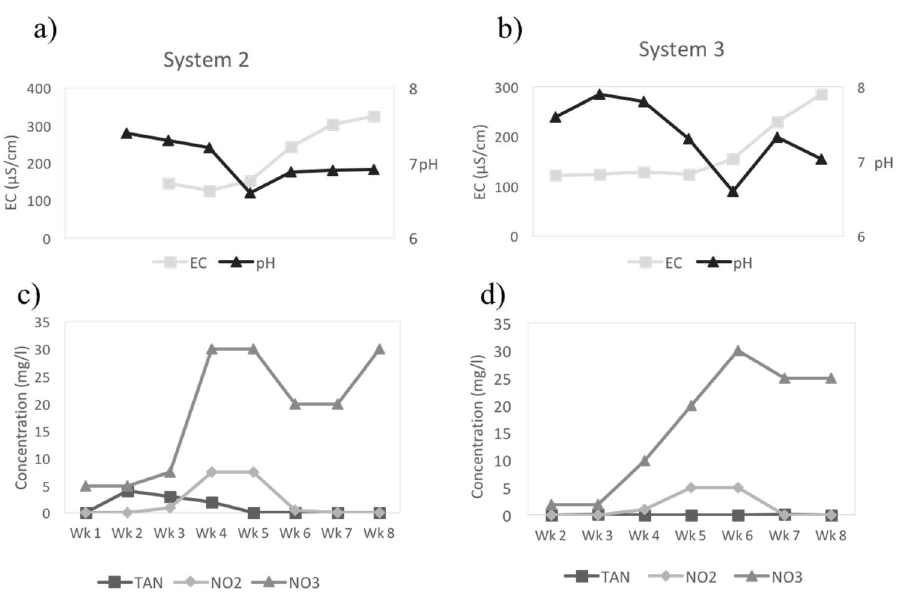
Figure 4. Biofilter stabilization in Systems 2 and 3: ( a , b ) show the measured conductivity (EC) and pH whereas ( c , d ) show the N-species dynamics in the system. All N-species are reported as N (TAN, NH 4 -N, nitrite, NO 2 -N, and nitrate, NO 3 -N). As ions accumulate in the system the EC rises whereas the pH drops because of the acidifying effects of nitrification. TAN rises at first, and as nitrifying bacteria establish, they eliminate TAN (NH 4 -N), the same happens with nitrite (NO 2 -N) as more bacteria populate the system. A fully mature system can be seen in Week 7 as TAN and nitrite are no longer detectable.